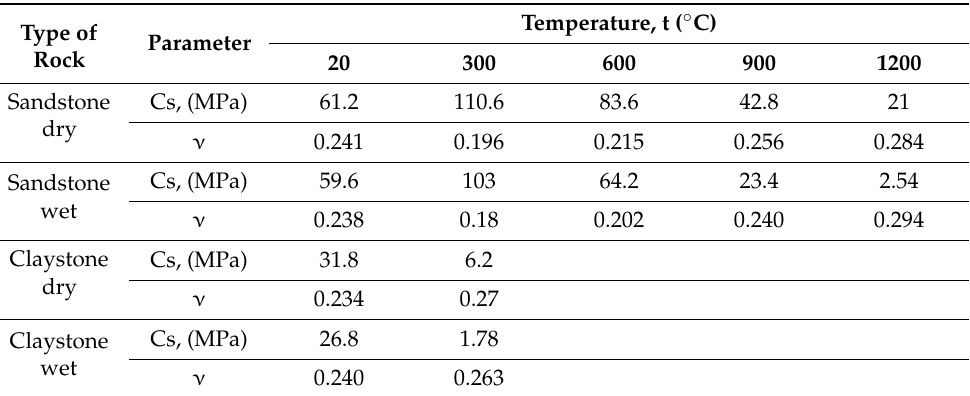
Table 1. Comparison of the results of compressive strength and Poisson’s ratio in relation to high-